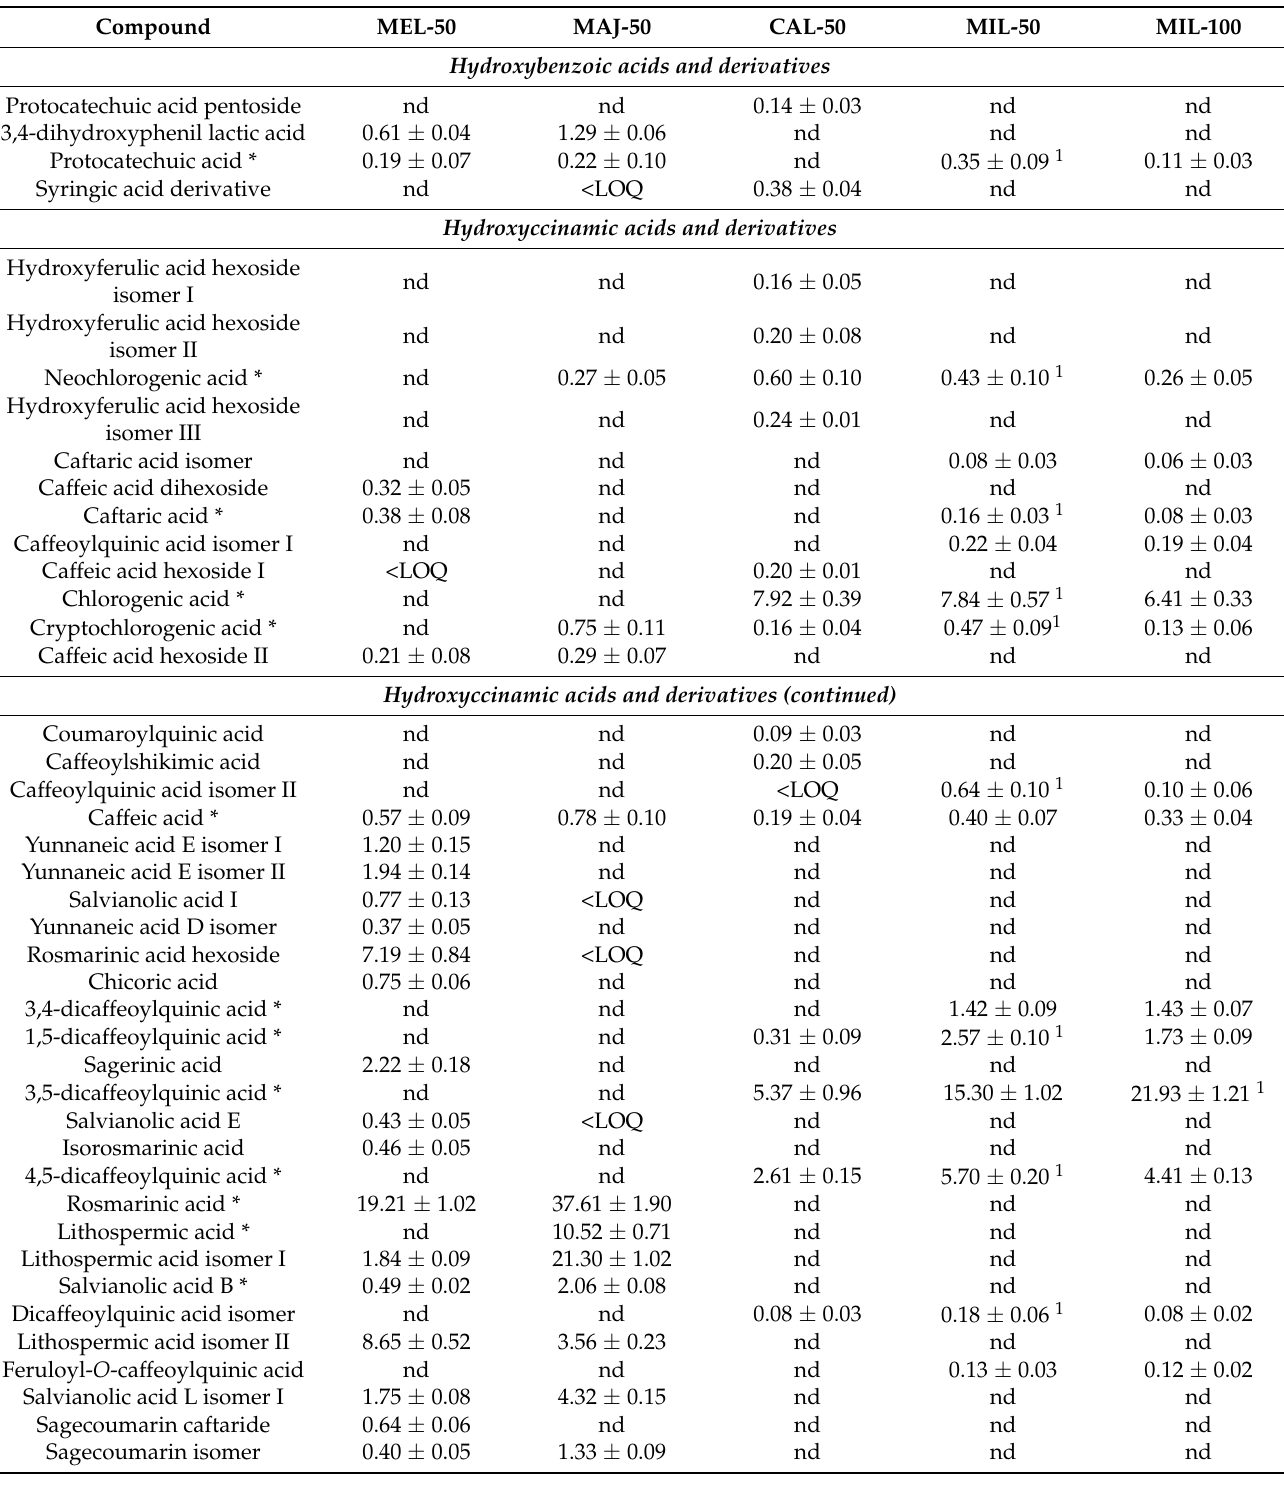
Table 3. Phenolic composition of the selected UAE extracts. MEL, Melissa officinalis L., MAJ, Origanum majorana L., CAL, Calendula officinalis L., MIL, Achillea millefolium L. Results are expressed in mean ± S.D. (mg/g extract). Compound MEL-50 MAJ-50 Hydroxybenzoic acids and